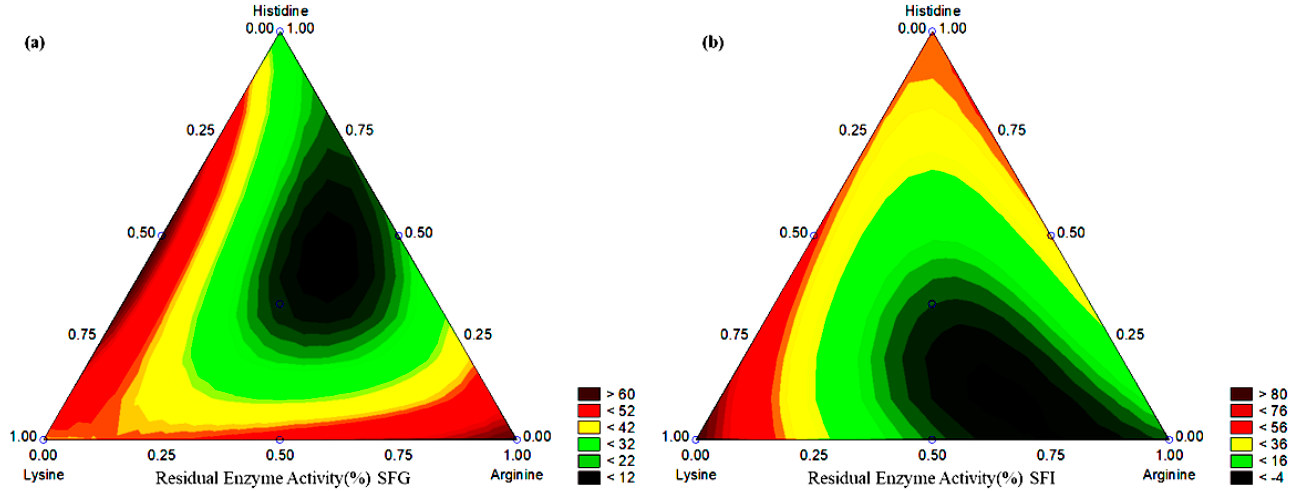
Figure 2. Contour curve of the tested systems for residual enzyme activity (%) in ( a ) SFG and ( b ) SFI. Amino acids may have different properties of protein protection and